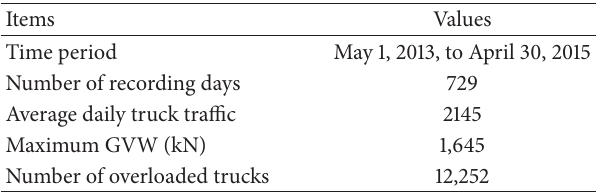
Table 1: Overview of the WIM measurement.